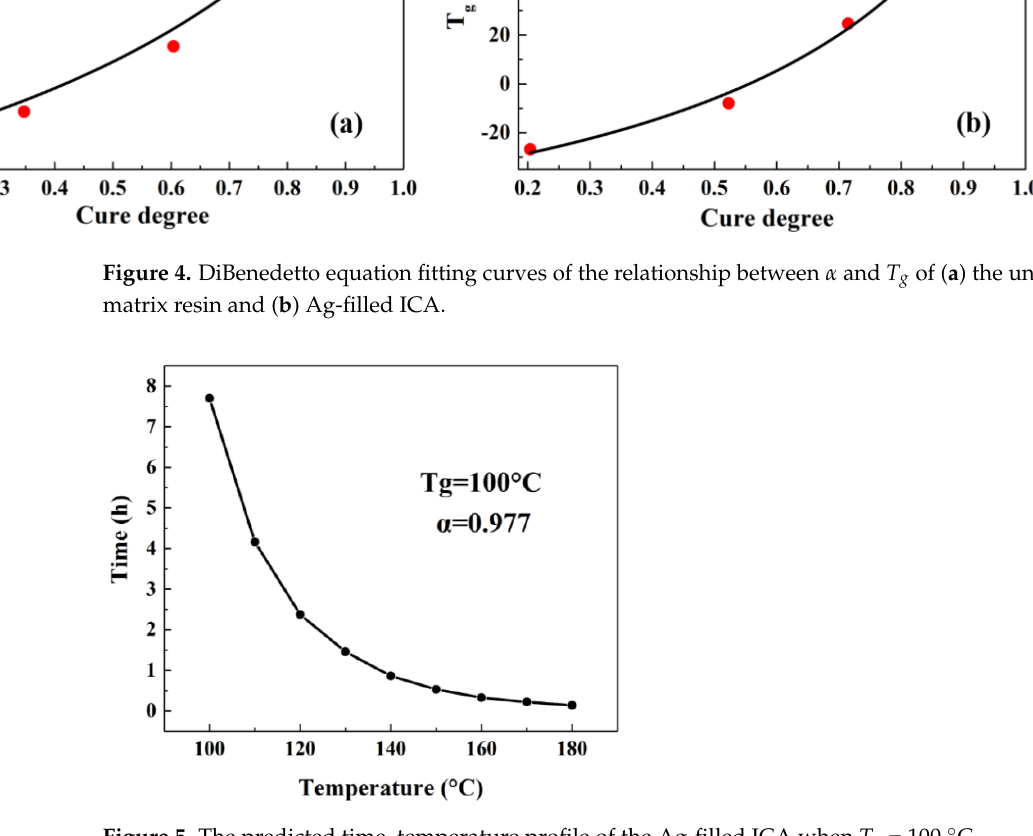
Figure 5. The predicted time–temperature profile of the Ag-filled ICA when T g = 100 °C.